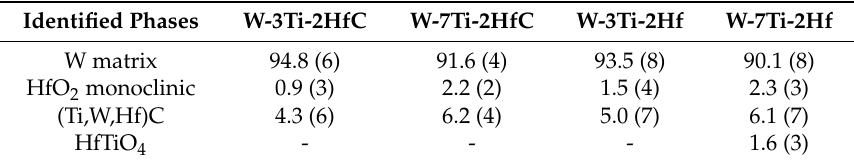
Table 3. Phase analysis of sintered samples by XRD quantitative Rietveld refinement noted in weight percent.